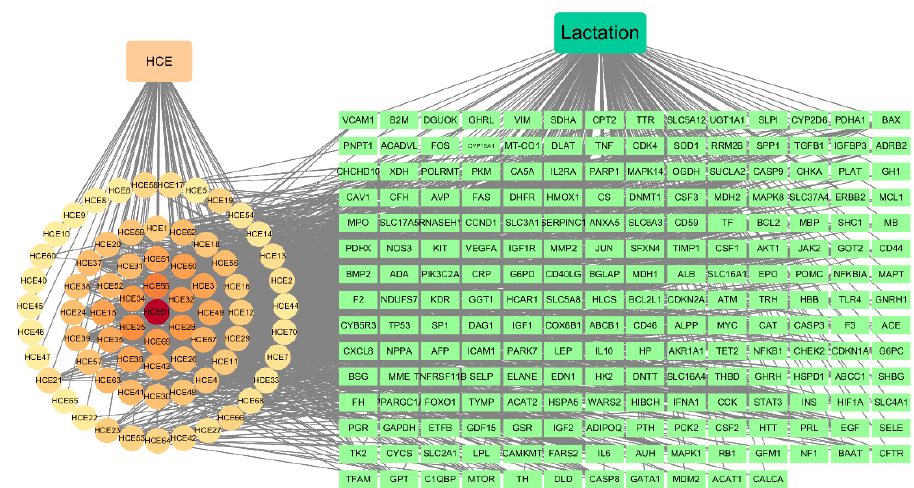
Figure 3. HCE-targets-lactation network. Circular nodes: compounds of daylily; Square nodes: common targets of daylily and lactation.